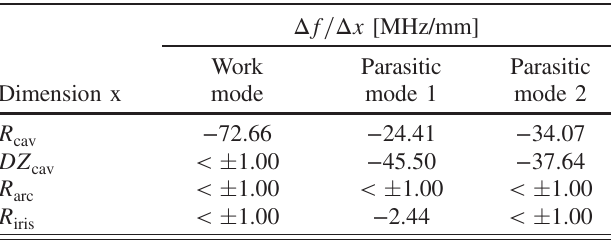
TABLE VI. Frequency sensitivity to different geometric param- eters of the working mode and the parasitic modes of the storage cavity.